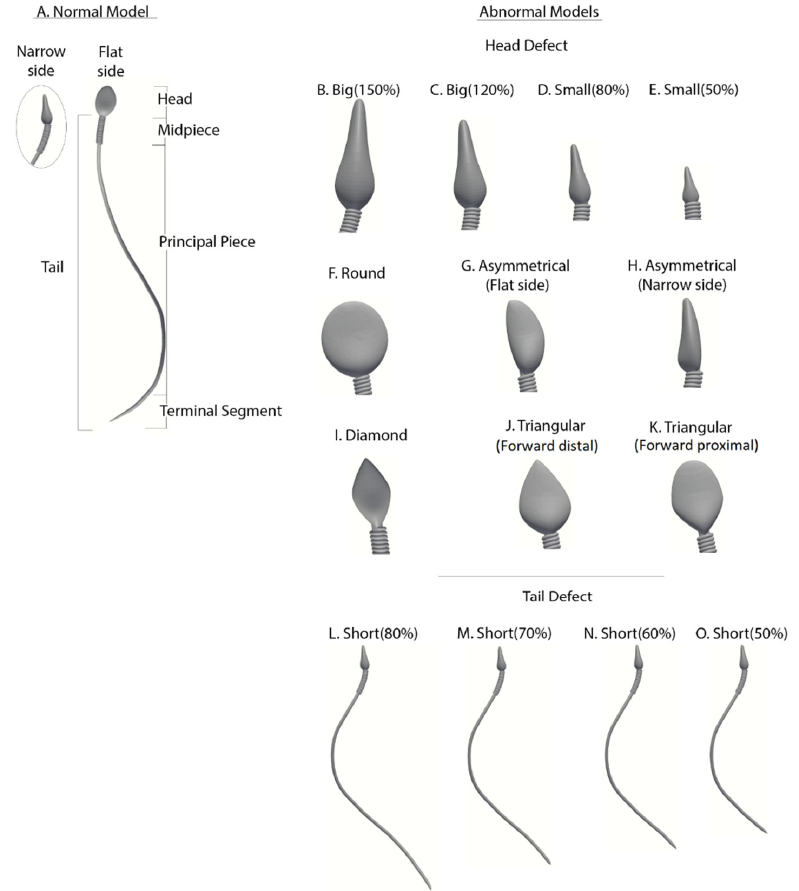
Figure 3. Normal and abnormal sperm cell models (according to the WHO classification). ( A ) Normal sperm cell model. ( B – K ) Different morphological abnormalities among sperm cells, ( B – E ) abnormali- ties in head size, ( F – K ) abnormalities in head shape, and ( L – O ) abnormalities in tail